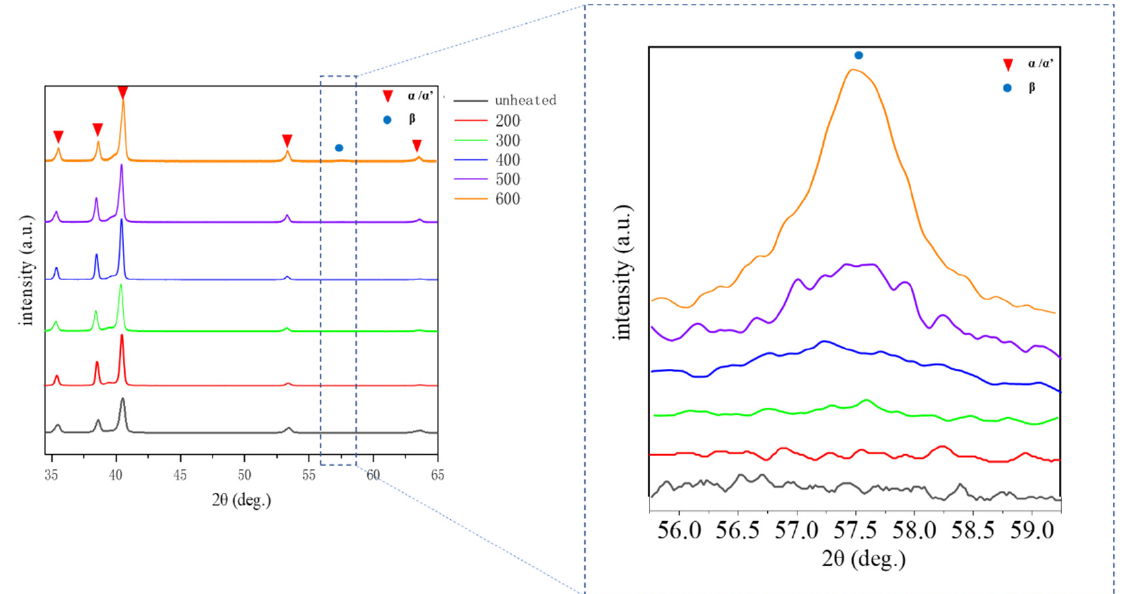
Figure 4. The XRD patterns of the Ti-6Al-4V alloy samples manufactured at different powder bed temperatures.